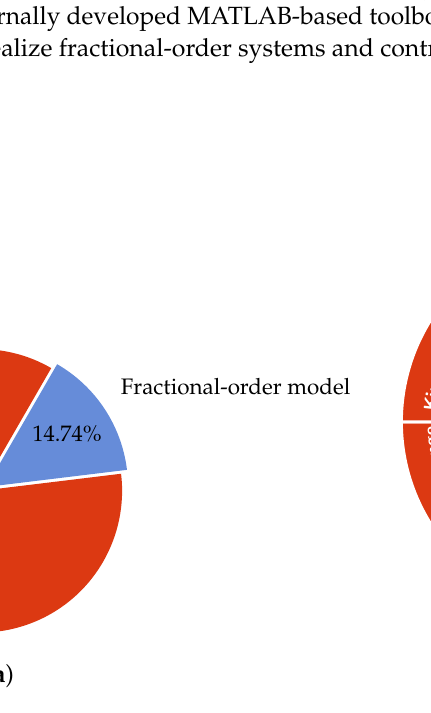
Figure 3. Summary of modelling details from Table 1. ( a ) Type of modelling approach. ( b ) Various types of modelling techniques.